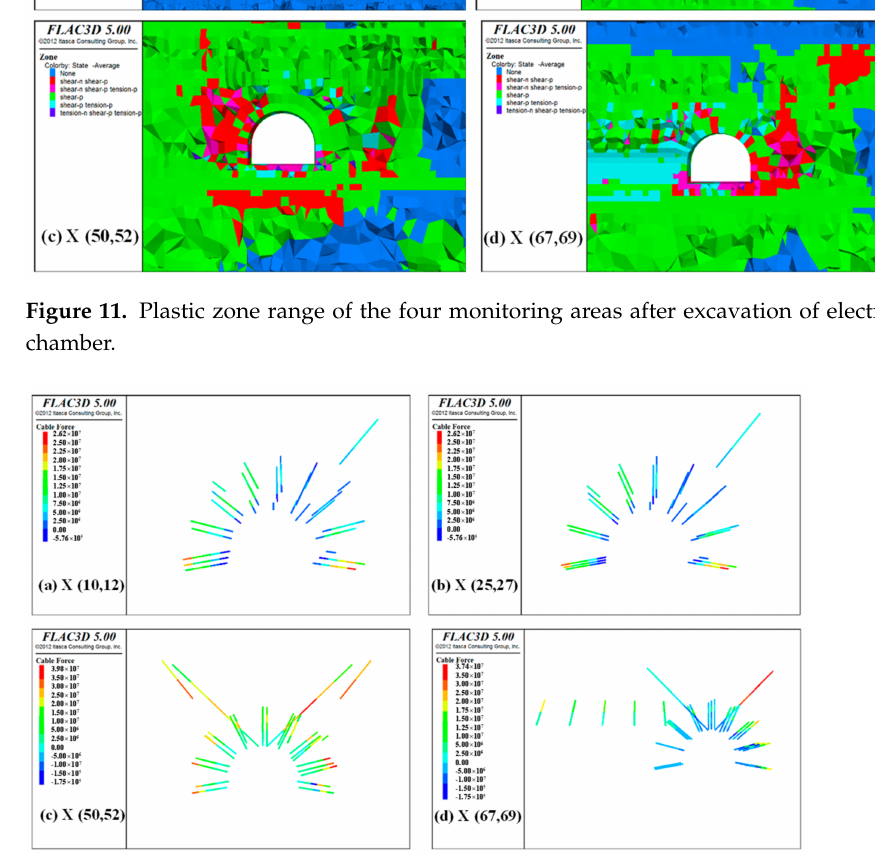
Figure 12. Cable force of the four monitoring areas after excavation of electromechanical chamber.